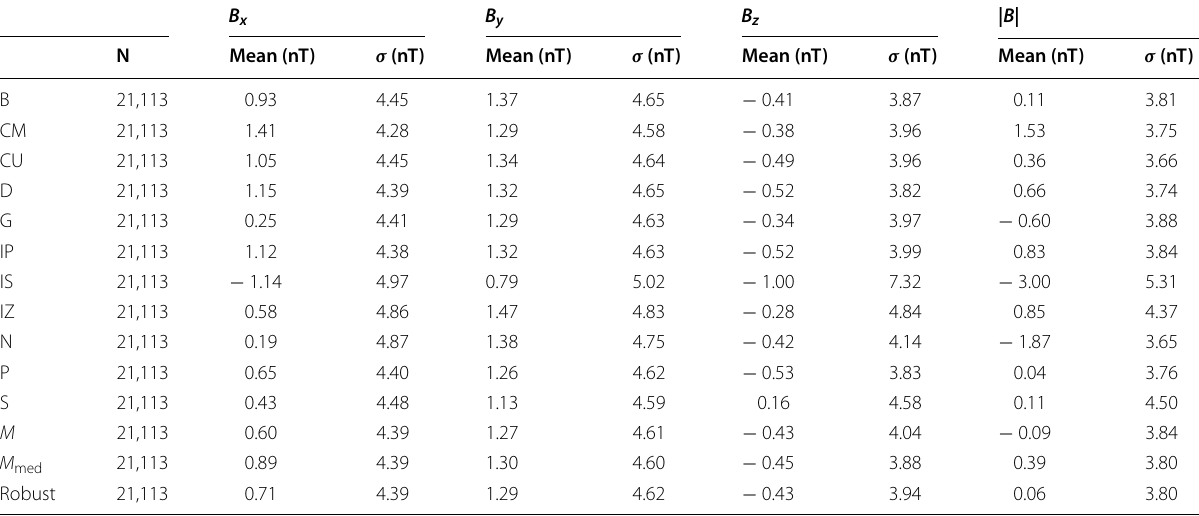
Table 3 Statistics of residuals between DGRF-2015 candidates and Swarm A/B measurements (equatorward of ± 55 ◦ QD latitude) from 15 December 2014 to 15 January